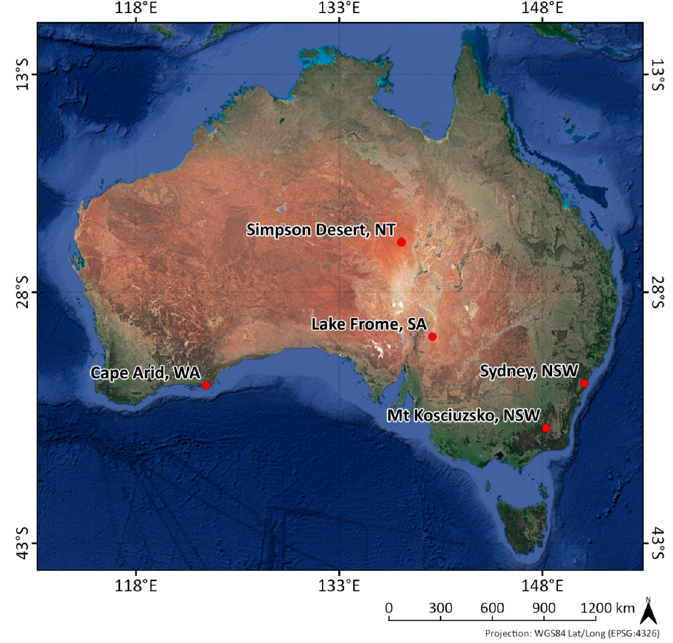
Figure 2. Overview of the locations chosen for further analysis. Imagery: Google, Landsat/Copernicus.